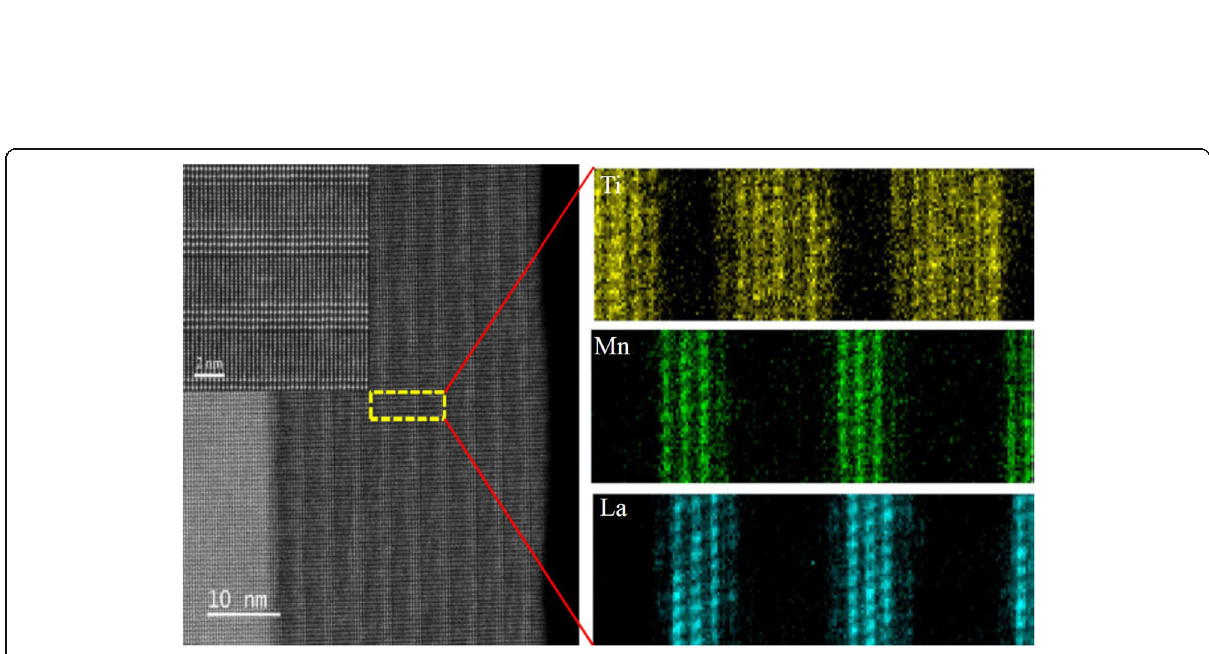
Fig. 13 STEM image of the cross-sectional elemental mapping measured by spatially resolved electron energy loss spectroscopy for the La 0.7 Sr 0.3 MnO 3 /SrRu 0.8 Ti 0.2 O 3 superlattice of [1.2/2.4] 10 , grown on NdGaO 3 (NGO)(001). The sample written as [m/n] N , where the numbers of m and n in square brackets denoting the thicknesses of the LSMO and SRTO layers in nanometers, respectively, and the subscript N representing the repeated number of LSMO layers. Reproduced with permission of